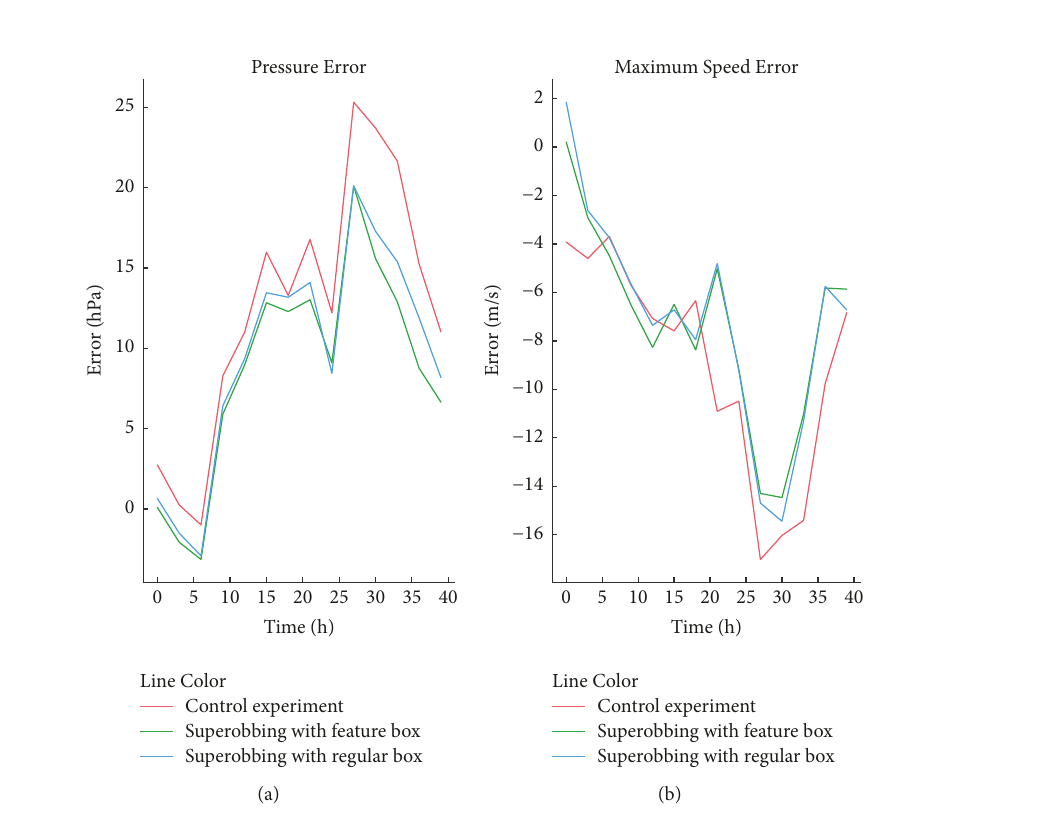
Figure 8: Pressure and maximum wind speed forecast error of the typhoon eye.